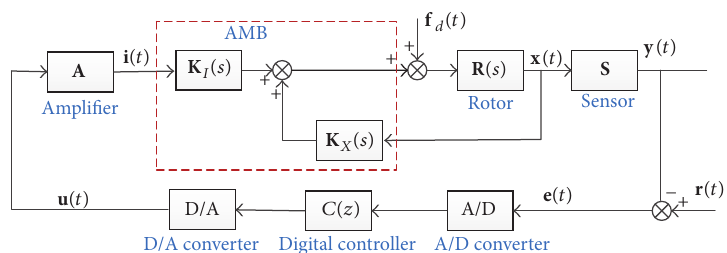
Figure 6: The closed-loop AMB system.